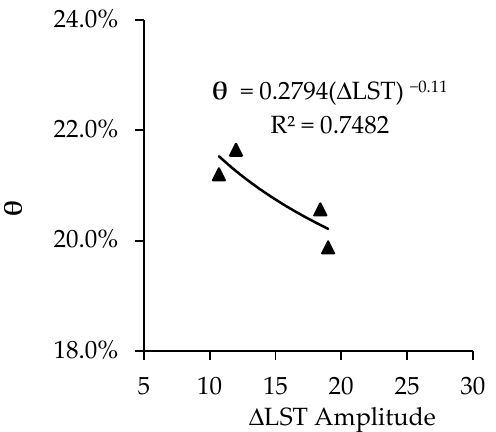
Figure 17. Vegetation-covered land Diurnal Surface Temperature Difference variation ( ∆ LST) vs. θ (power curve fit).